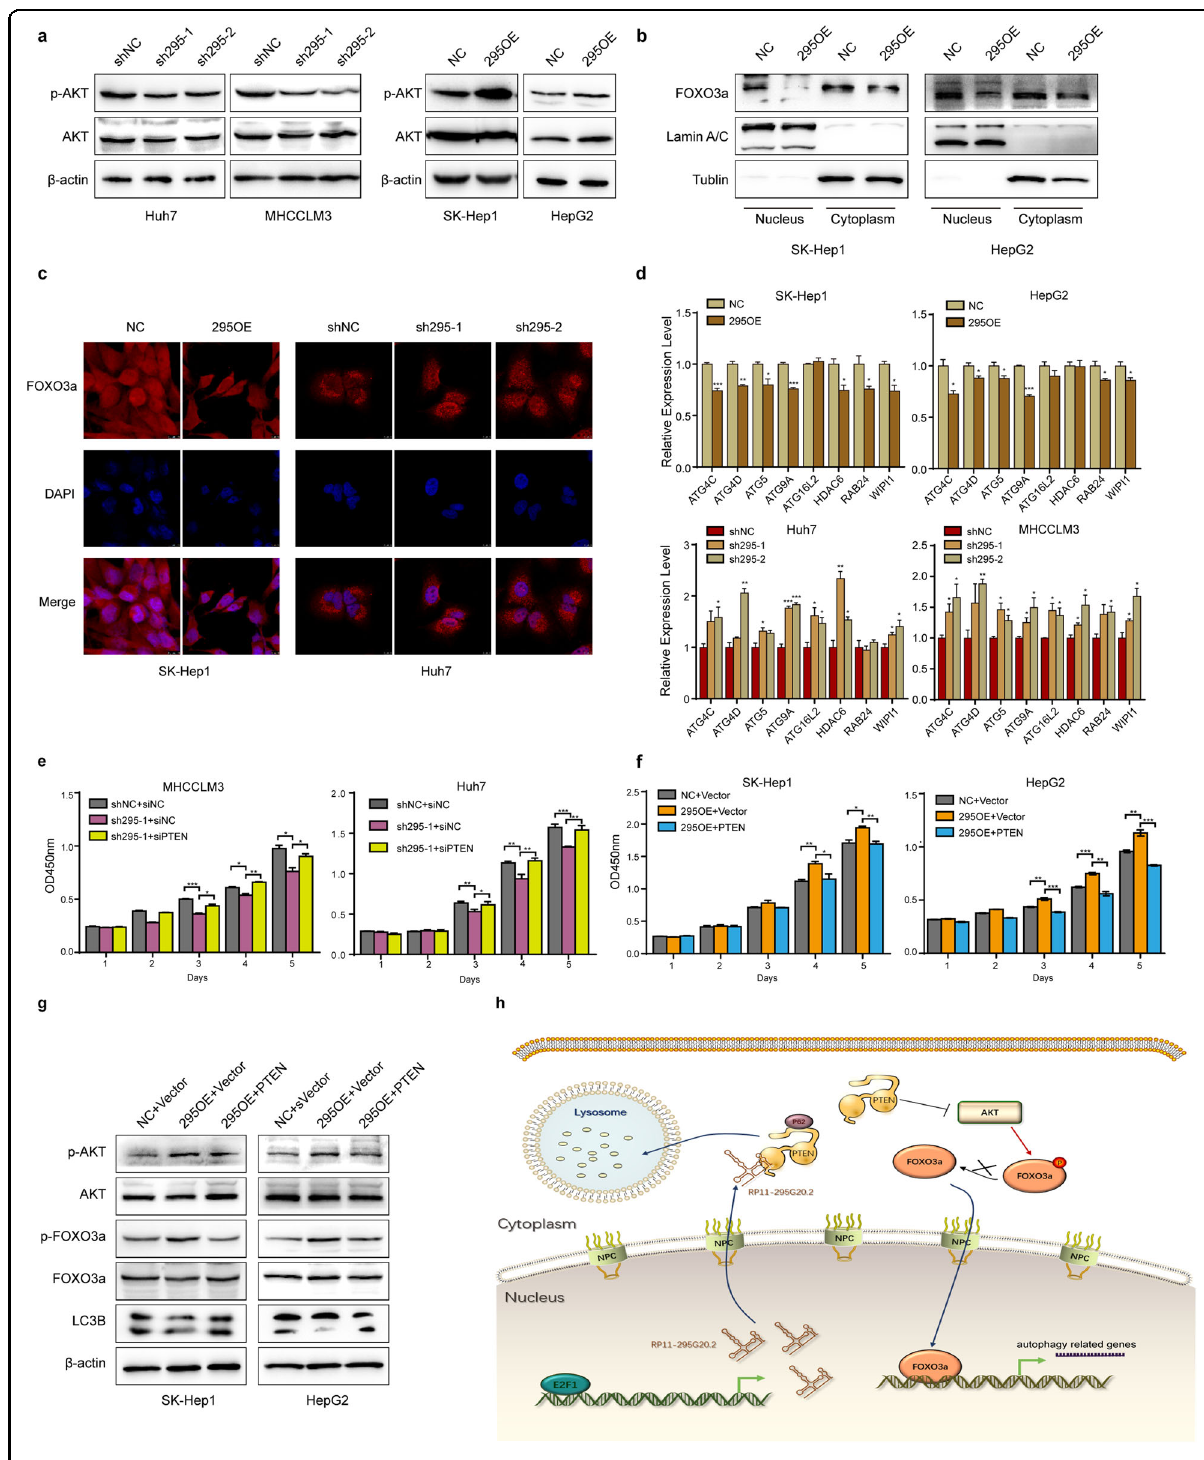
Fig. 6 (See legend on next